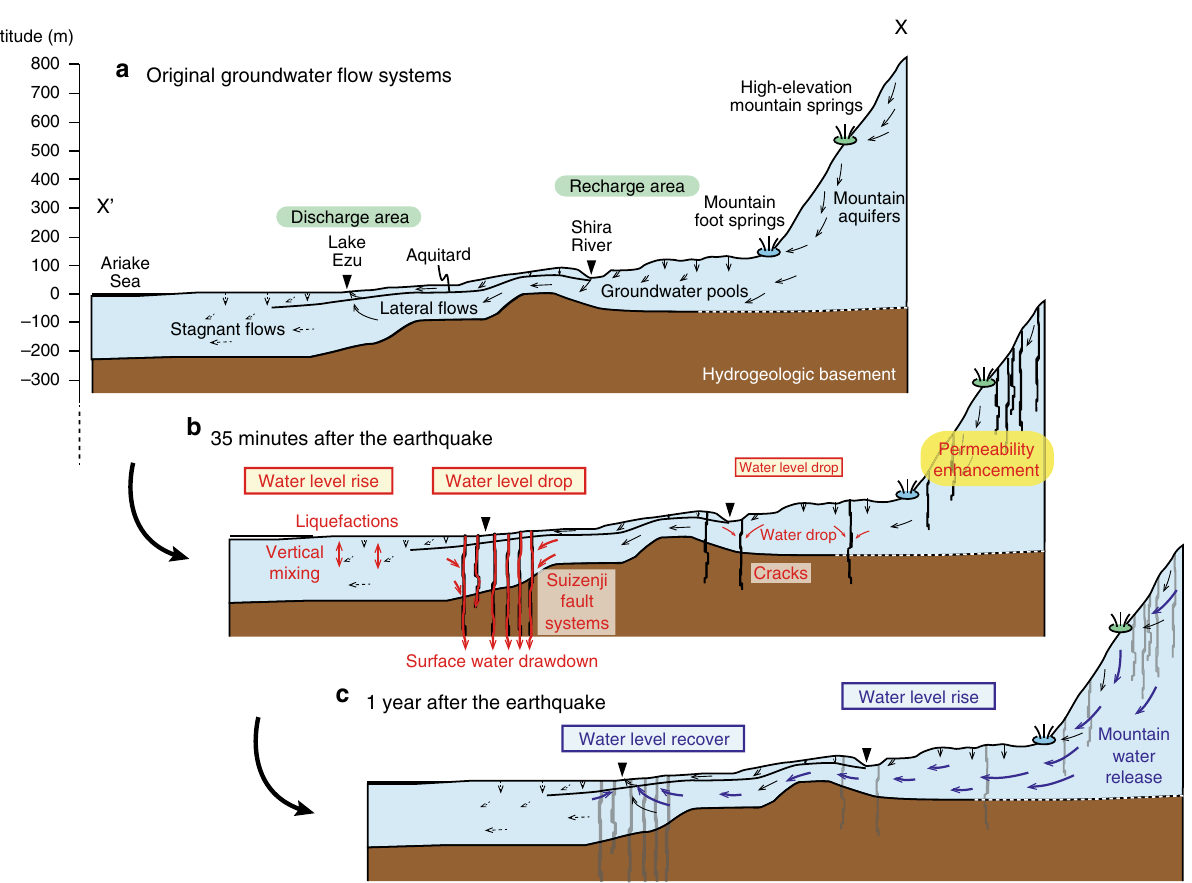
Fig. 4 Cartoons showing coseismic hydrogeological changes. a Schematic cross-section X – X ′ (see Fig. 1a for its location) showing original hydrogeological systems in the study area. b , c Cross-sections showing coseismic hydrogeological changes 35 min and 1 year after the main shock of the 2016 Kumamoto earthquake, respectively. Coseismic groundwater drawdown mechanisms are after ref. 6